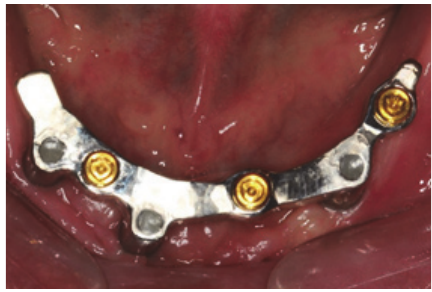
Figure 10: Milled implant framework tried in the mouth.